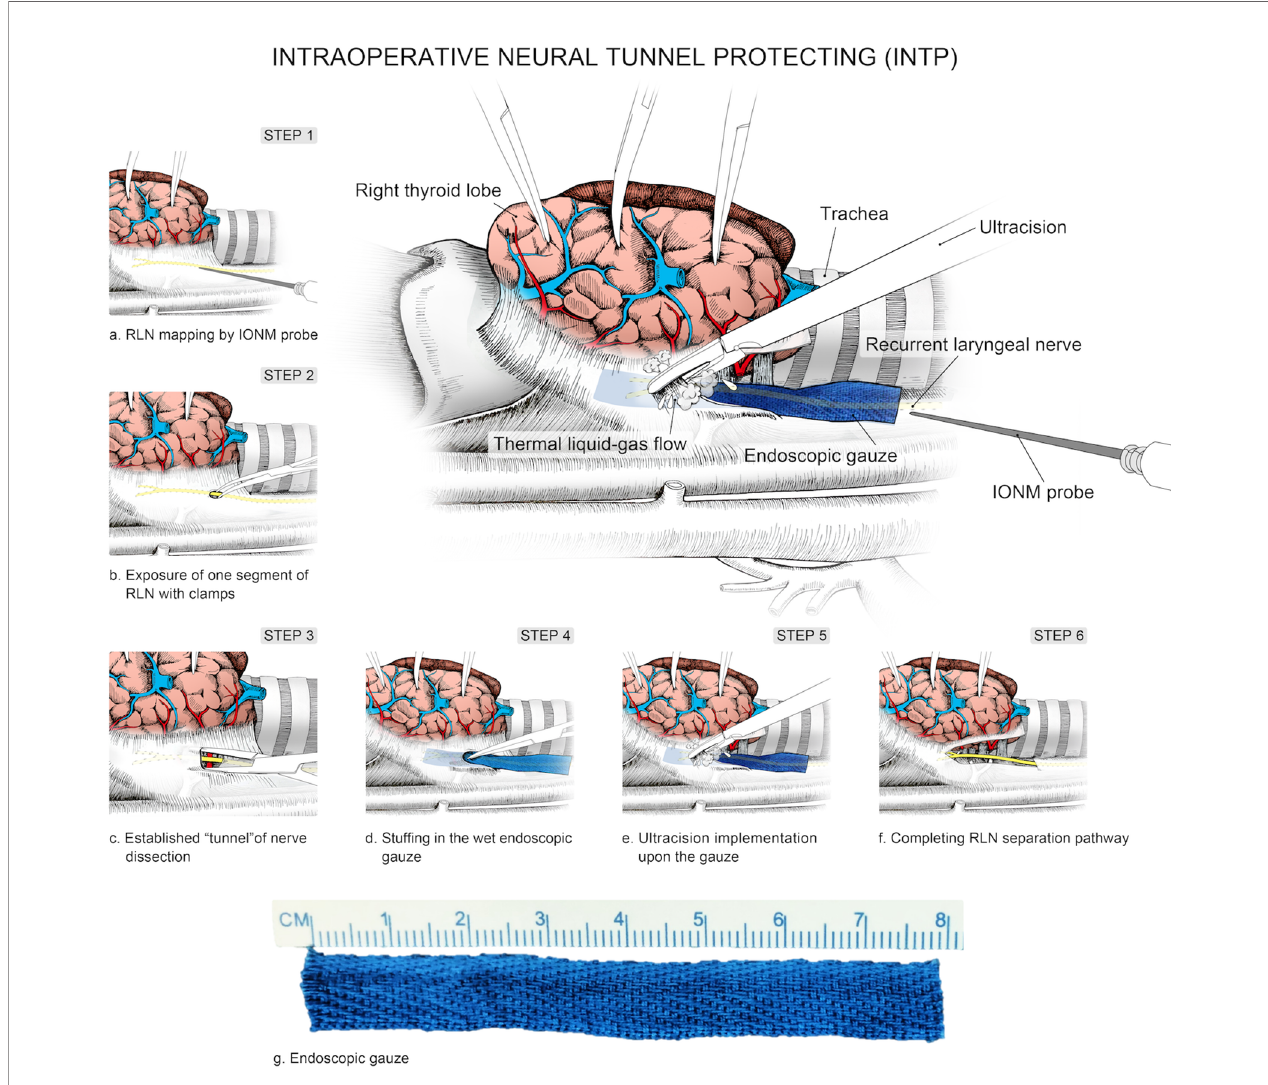
FIGURE 2 | Schematic diagram of intraoperative nerve tunnel protecting